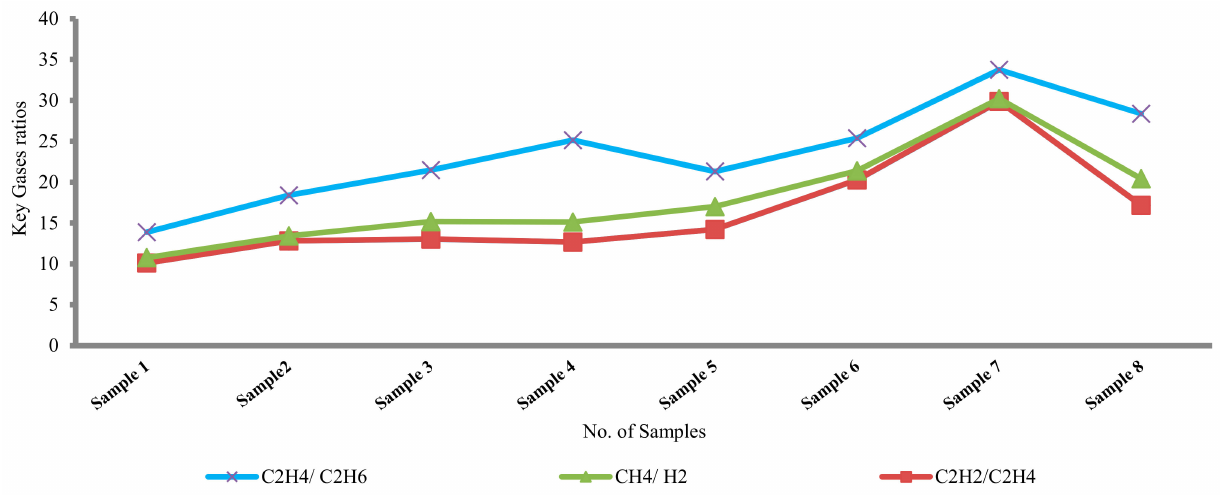
Figure 9. Analyzing the most common ratios in the case